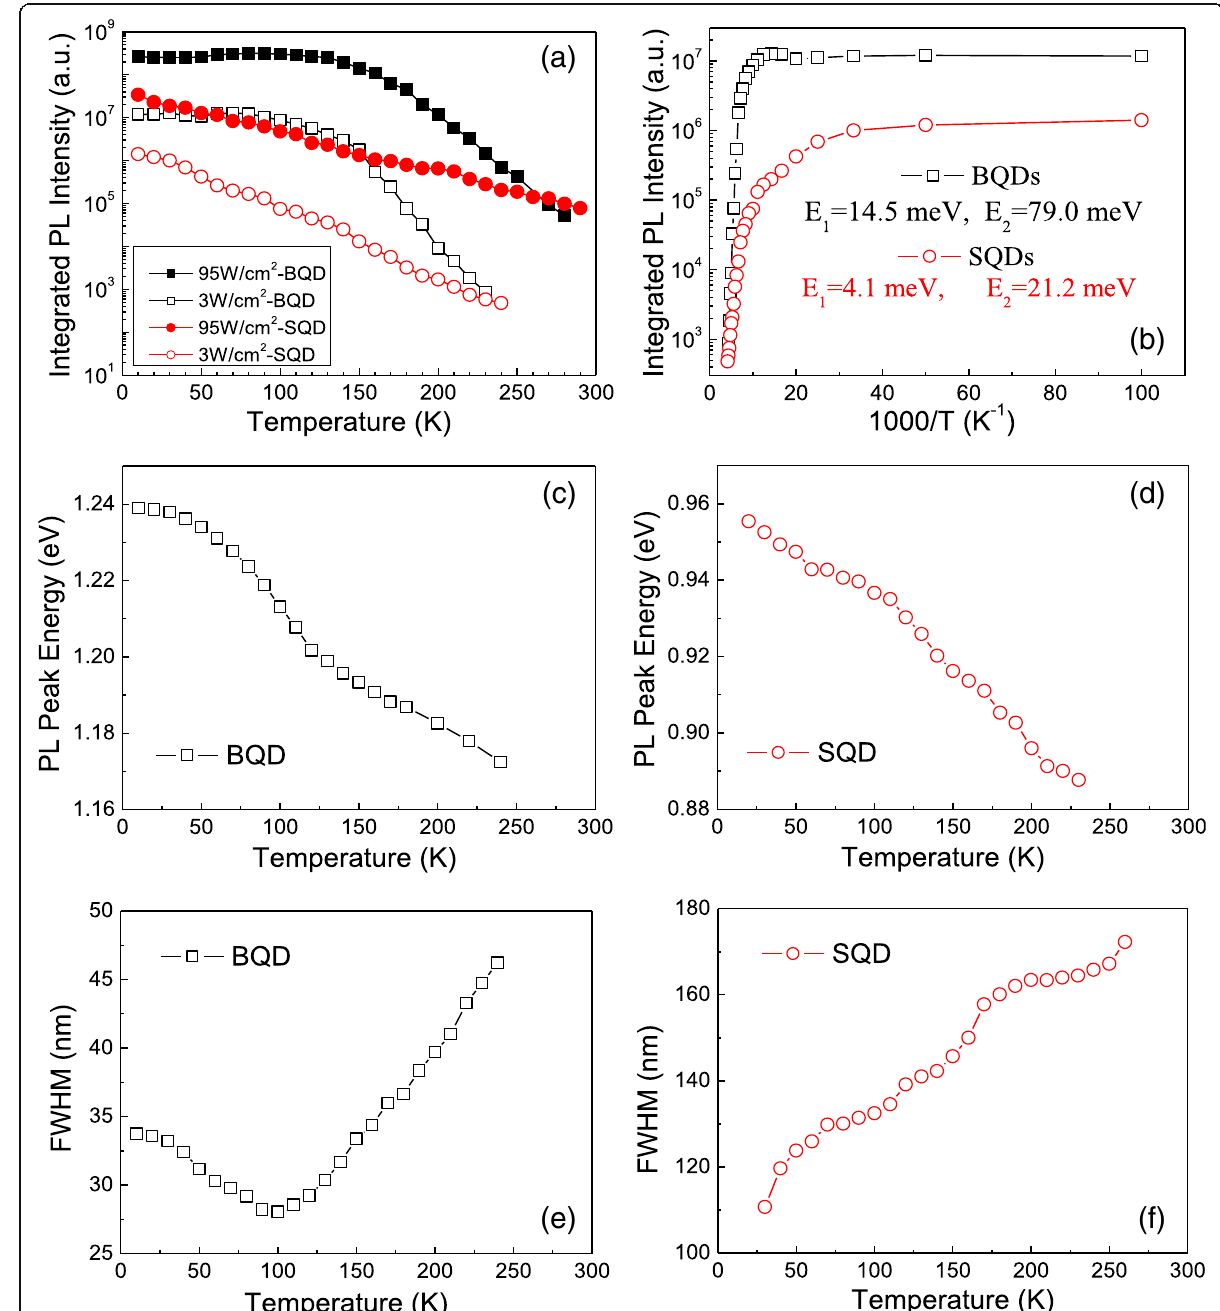
Fig. 4 a Integrated PL intensities of the BQDs and the SQDs as functions of temperature at different excitation intensities. b Arrhenius plot with an excitation intensity 3 W/cm 2 for the BQDs and the SQDs. The PL peak energy of c the BQDs and d the SQDs. The FWHM of e the BQDs and f the SQDs as functions of